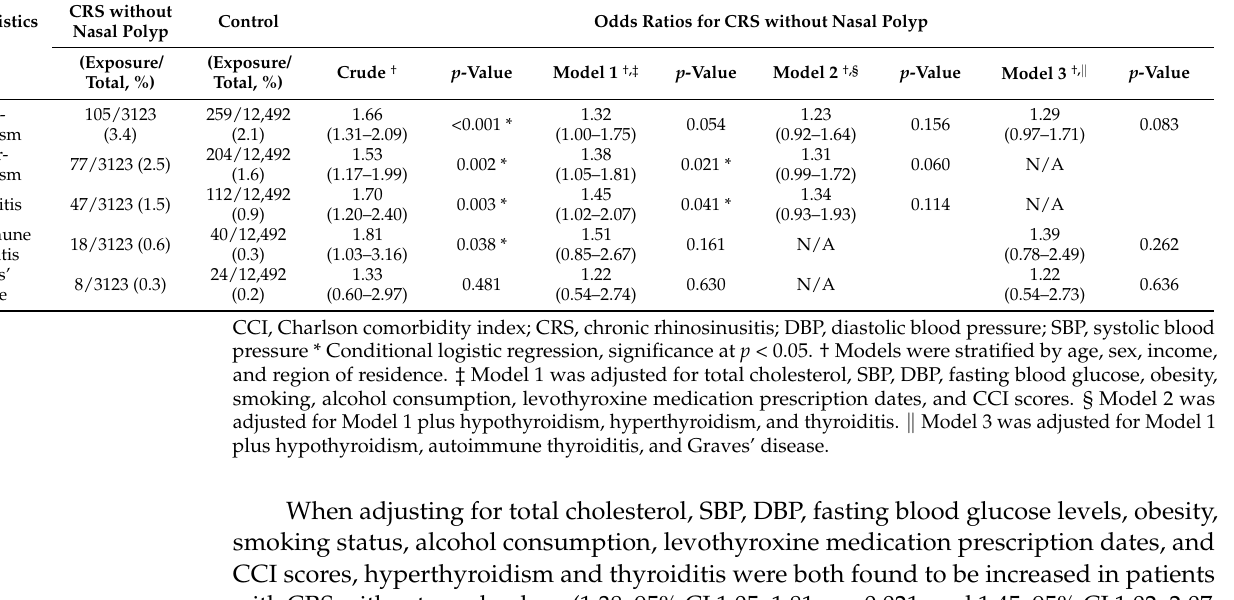
Table 4. Odds ratios (95% confidence interval) of each thyroid disease for total chronic rhinosinusitis without nasal